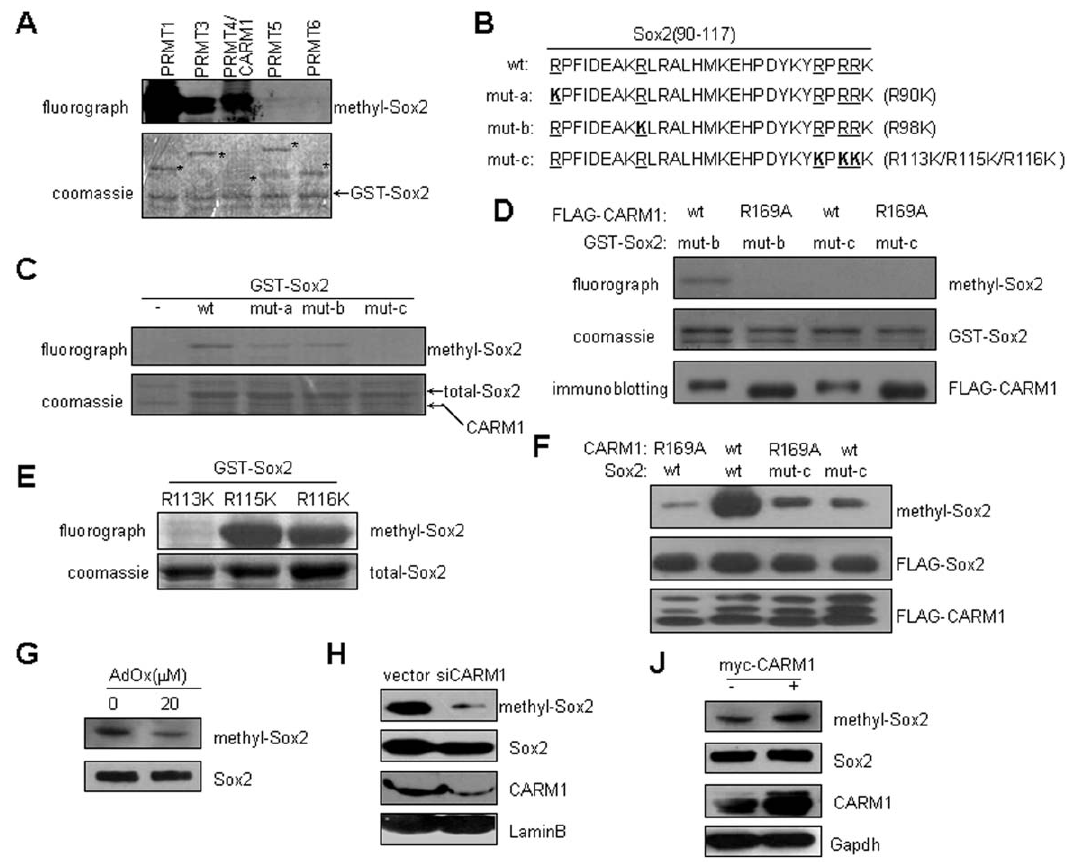
Figure 3. CARM1 methylates Sox2. (A) Methylation assays indicating methylation of Sox2 by PRMTs. Methylation signals were detected by fluorography. Total GST-Sox2 (arrowhead) and GST-PRMTs (asterisks) are shown by Coomassie brilliant blue staining. (B) The schematic representation of Sox2 methylation sites that are identified by mass spectrometry analysis. The sequence constitution of Sox2 mutants is shown, candidate methylation sites are underlined, and the substitutional lysine residues are in bold. (C and E) Methylation assays show Arg113 of Sox2 is the primary CARM1-methylated site. FLAG-tagged CARM1 was ectopically expressed in HEK293T cells and immunoprecipitated with anti-FLAG antibody. Equal amounts of FLAG-CARM1 immunoprecipitates were incubated with GST-Sox2 derivatives in the presence of [ 3 H]-SAM. (D) Methylation assays indicating methylation of Sox2 by CARM1. FLAG-CARM1 and FLAG-CARM1-R169A were ectopically expressed in HEK293T cells and immunoprecipitated with anti-FLAG antibody. Equal amounts of FLAG-CARM1 and FLAG-CARM1-R169A immunoprecipitates were incubated with GST-Sox2 and GST-Sox2-mut-c in the presence of [ 3 H]-SAM. Methylation signals were detected by fluorography. FLAG-CARM1 and FLAG-CARM1- R169A were detected with anti-FLAG antibody. Total GST-Sox2 or GST-Sox2-mut-c are shown by Coomassie brilliant blue staining. (F) Methylation of FLAG-Sox2 in MCF7 cells. Wild-type and mut-c of FLAG-Sox2 were overexpressed in MCF7 cells together with FLAG-CARM1 or FLAG-CARM1-R169A. Sox2 methylation at Arg113 was detected with anti-methyl-Sox2 antibody. (G) Methylation of endogenous Sox2 in P19 cells treated with AdOx. P19 cells were treated with AdOx for 24 hours. Sox2 methylation levels were detected with anti-methyl Sox2. (H) The effect of CARM1 knockdown with siCARM1 plasmid on Sox2 methylation in P19 cells. (J) The effect of CARM1 overexpression on Sox2 methylation in P19 cells. Myc-CARM1 ( + ) or Vector (-) were transfected into P19 cells and the Sox2 methylation levels were detected.